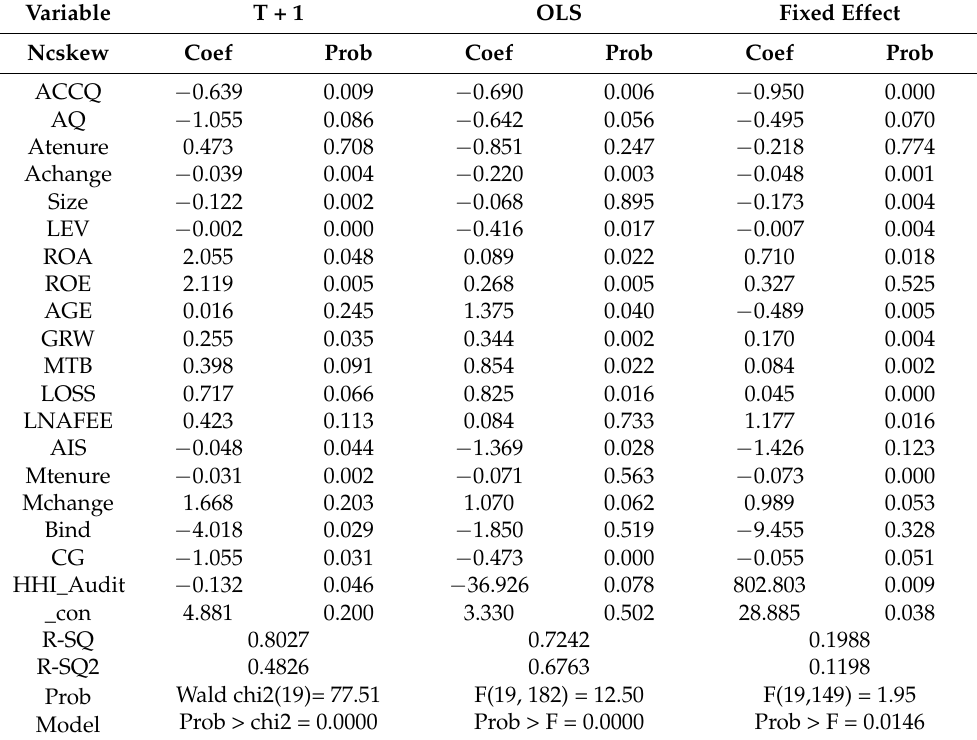
Table 11. The results of the